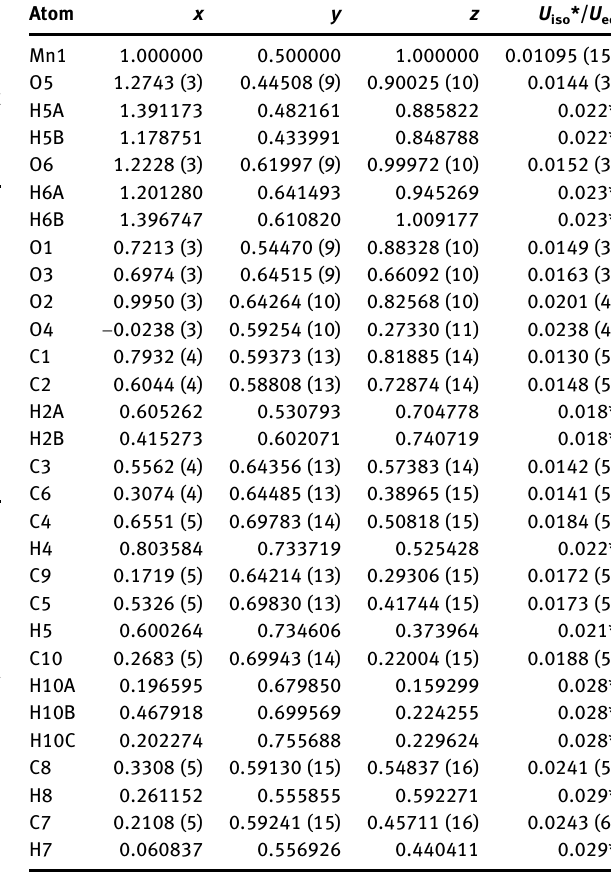
Table  : Fractional atomic coordinates and isotropic or equivalent isotropic displacement parameters (Å 